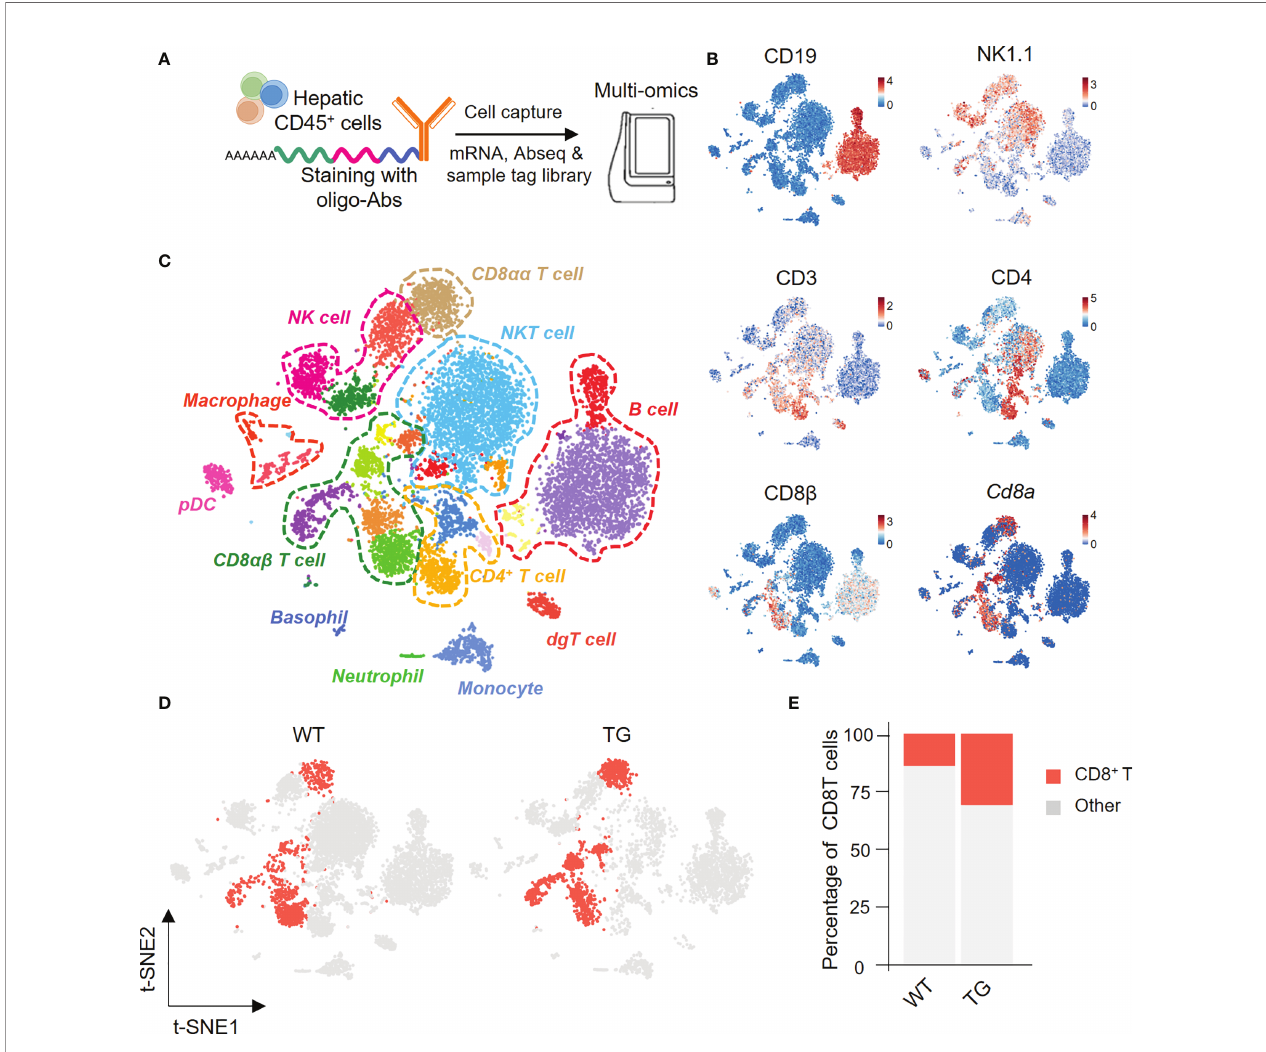
FIGURE 2 | Single-cell multi-omics analysis of hepatic immune cells from TG and control mice. (A) Schematic representation of the work fl ow for single cell preparation, labels for antibodies, cell capture and library preparation. (B) The immune cell subsets identi fi ed with a combination of antibodies and genes, include CD19, NK1.1, CD3, CD4, CD8 b and Cd8 a . (C) Merged t-SNE plots of twelve immune subsets in livers of WT and TG mice. (D) CD8 + T cells from WT and TG mice highlighted with Split t-SNE plots. (E) Percentage of CD8 + T cells in WT and TG